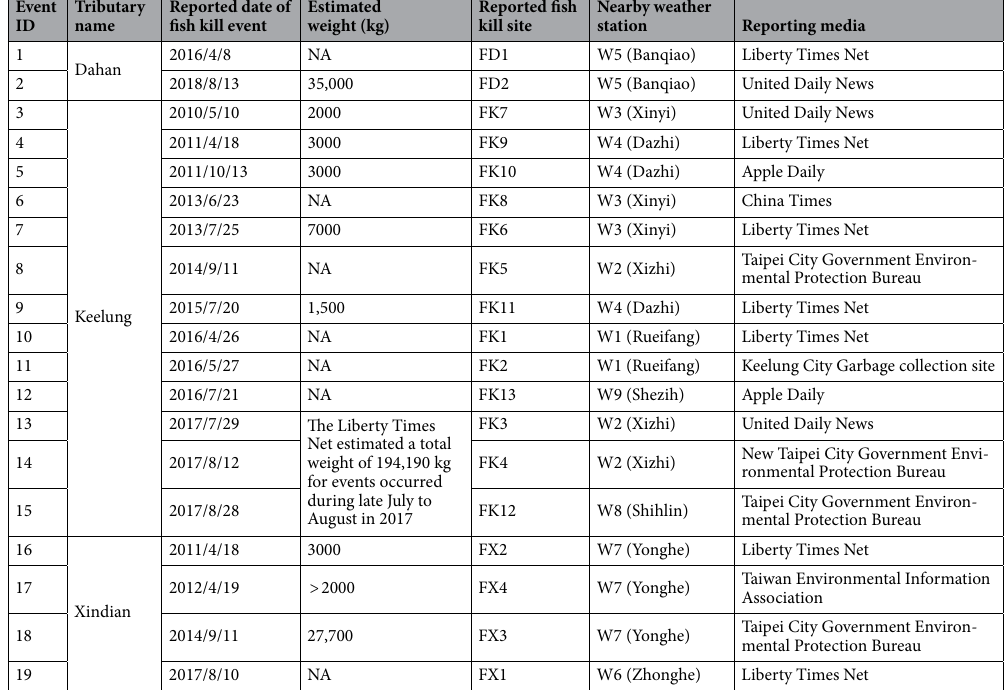
Table 1. Detailed information of the assembled 19 fish kill events in one of the three tributaries (i.e., Dahan, Keelung, or Xindian River) of Danshuei